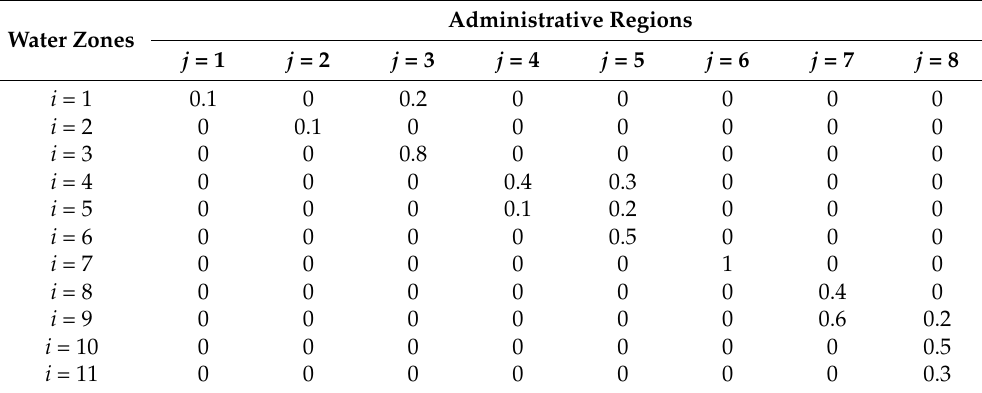
Figure 2. Geographical position and study regions of the Yinma River Basin. Table 1. Relationships between regional pollutant emission and receiving water.